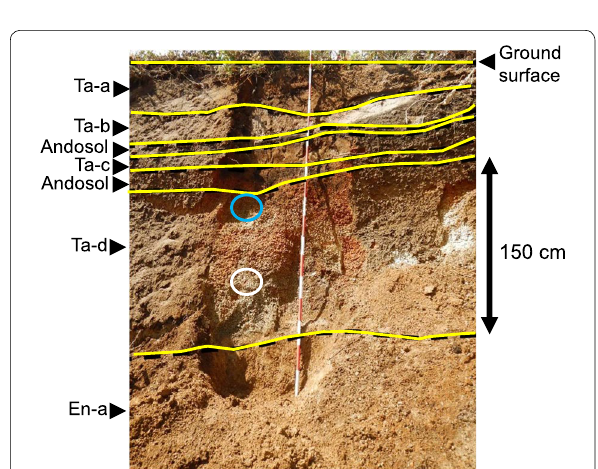
Fig. 7 An example of soil stratification at the location marked by a blue square in Fig. 1. Ta: tephra produced by the Tarumae volcano. a in 1739, b in 1667, c at 2500 ybp, and d at 9000 ybp. En-a: tephra produced by the Eniwa volcano at 20,000 ybp (Nakagawa et al. 2018). Blue and white circles show the locations of soil sampling